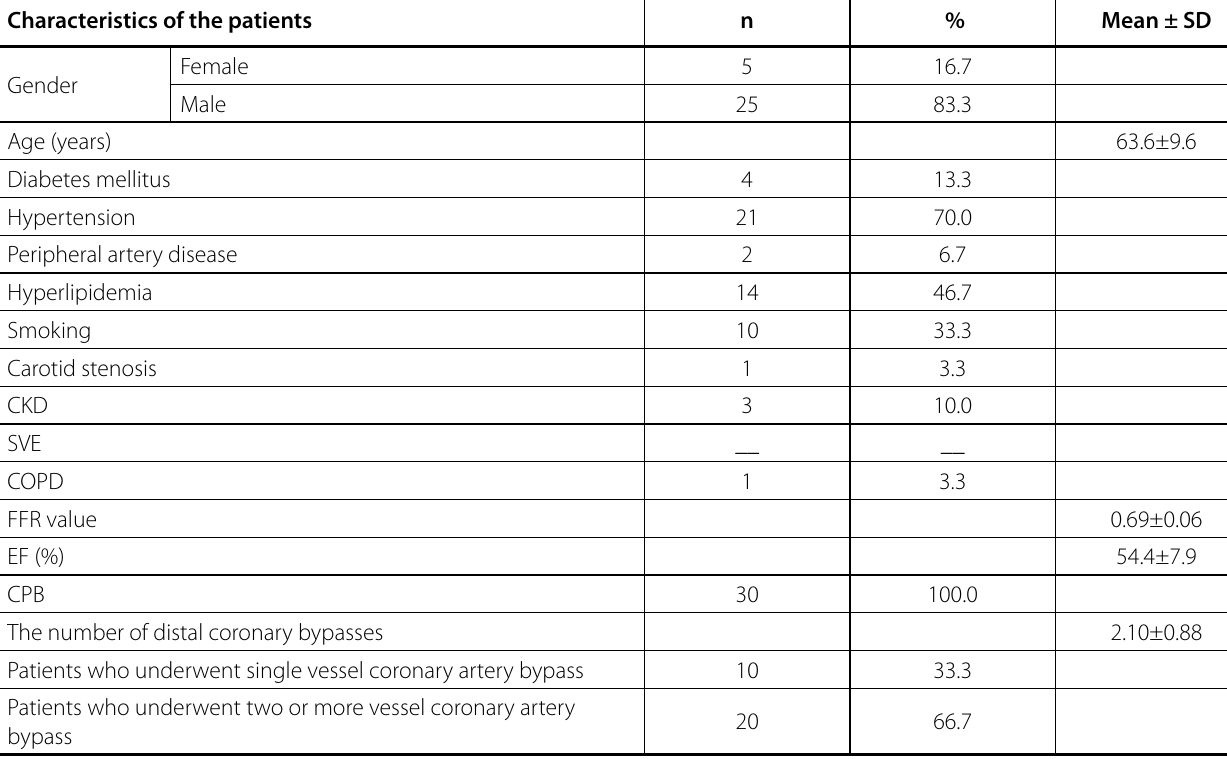
Table 1 . Basic demographic and intraoperative characteristics of the patients. Characteristics of the patients